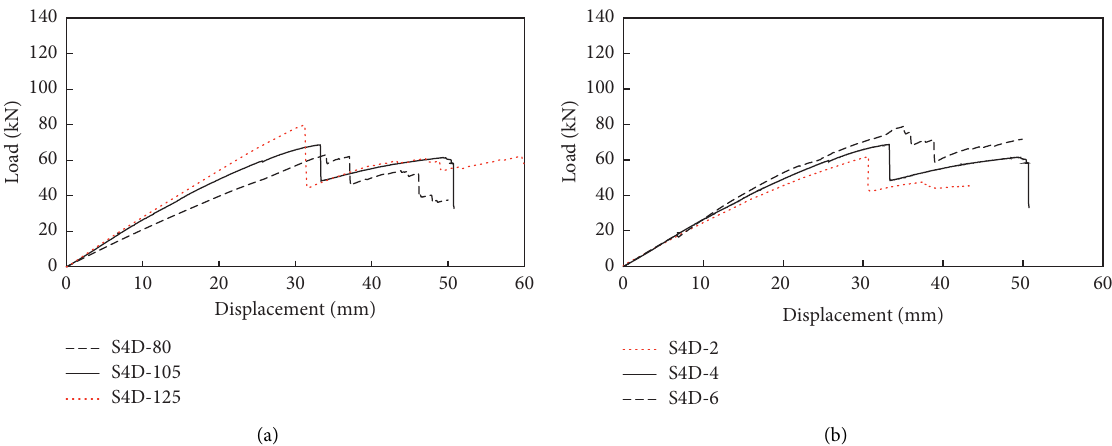
Figure 10: Simulated load-displacement curves of S4D: (a) with different height of vertical webs and (b) with different GFRP layers on the compressive